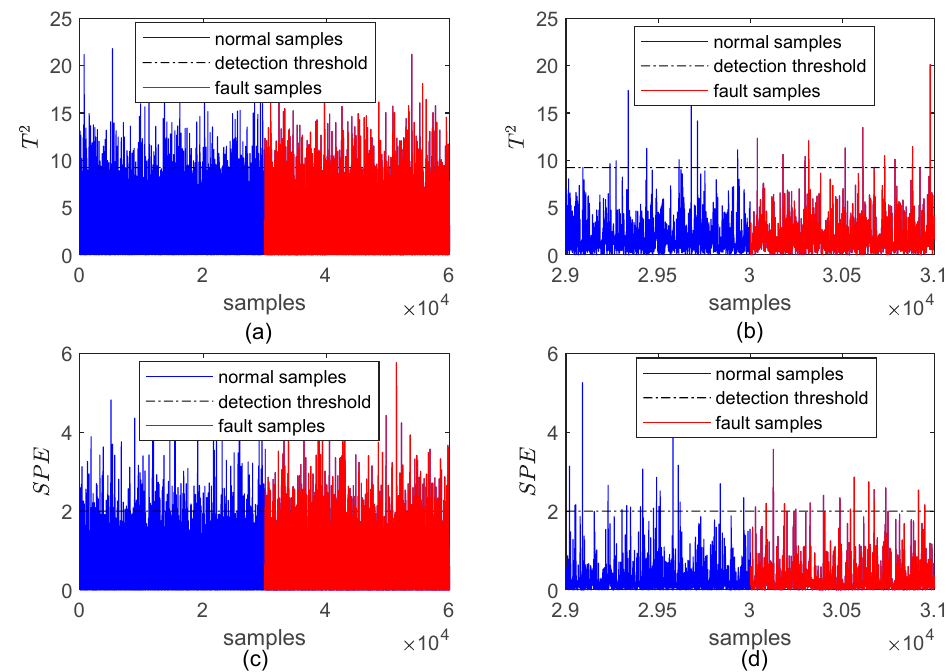
Figure 3. Results of detecting fault f 1 using the T 2 and squared prediction error (SPE) statistics: ( a ) T 2 statistic result for all on-line samples; ( b ) the result for the T 2 statistic at 1000 samples before and after insertion of the fault; ( c ) SPE statistic result for all on-line samples; ( d ) the result for the SPE statistic at 1000 samples before and after insertion of the fault.